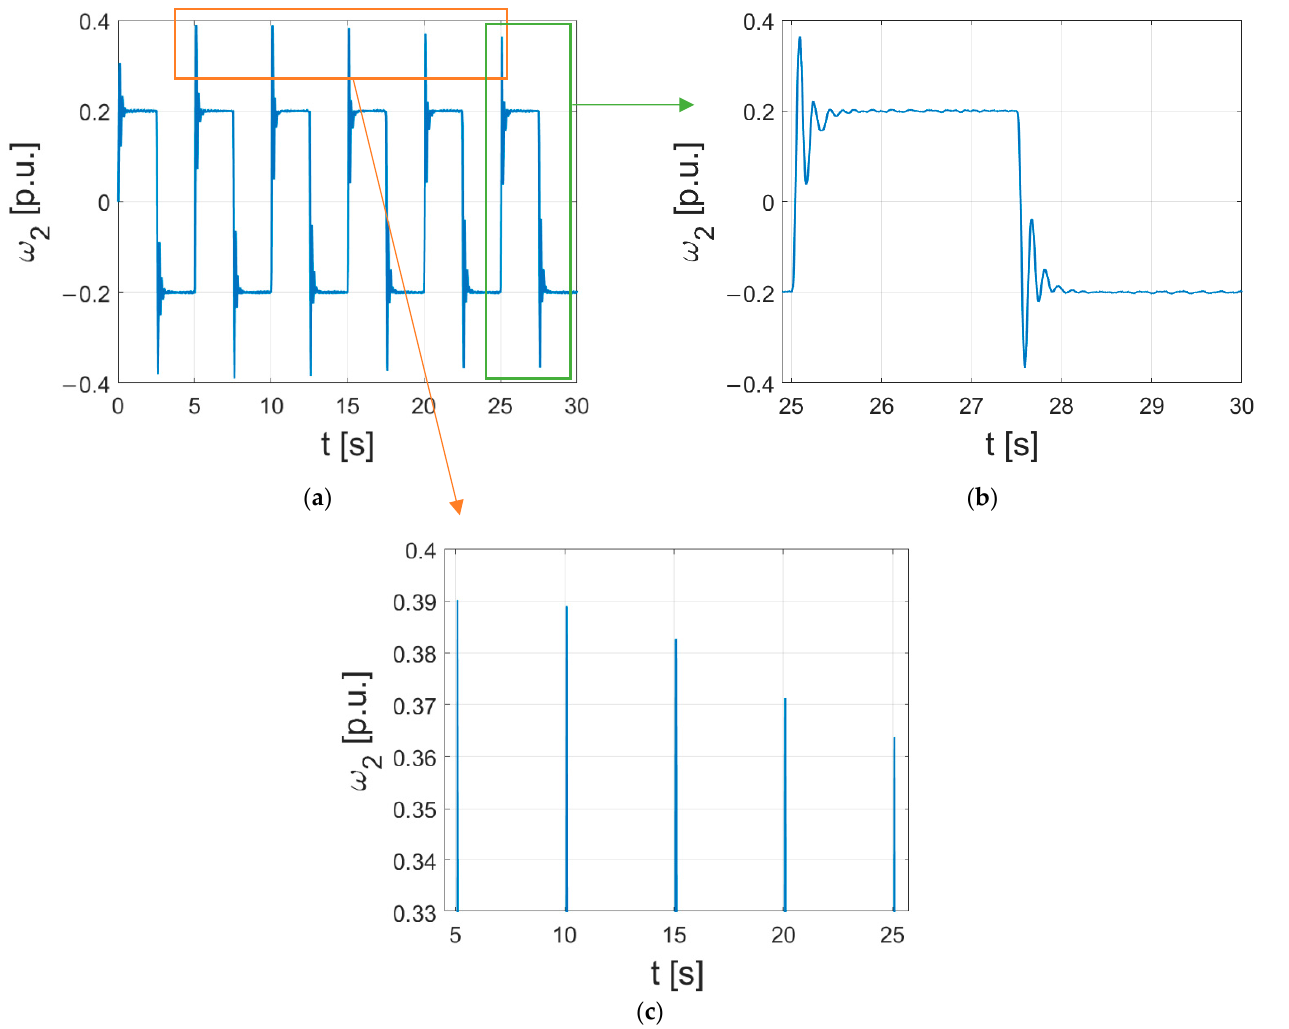
Figure 11. The work of the controller under nominal conditions: ( a ) the general overview of the experimental run; ( b ) a zoom-in presenting the final reversions of the experimental run; ( c ) a zoom-in presenting the highest value of the load angular speed after every reversion.